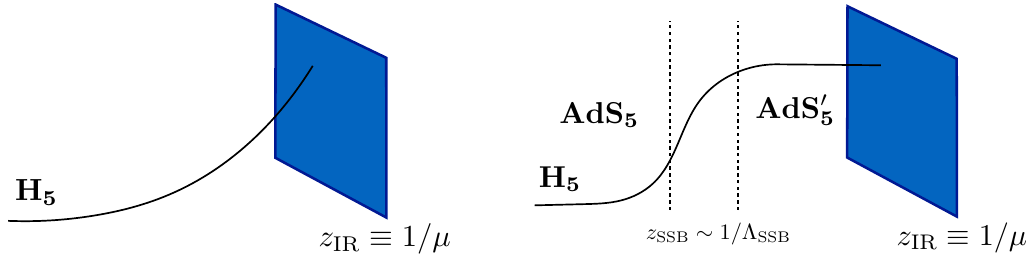
Figure 8 . Models of type I (left) and type II